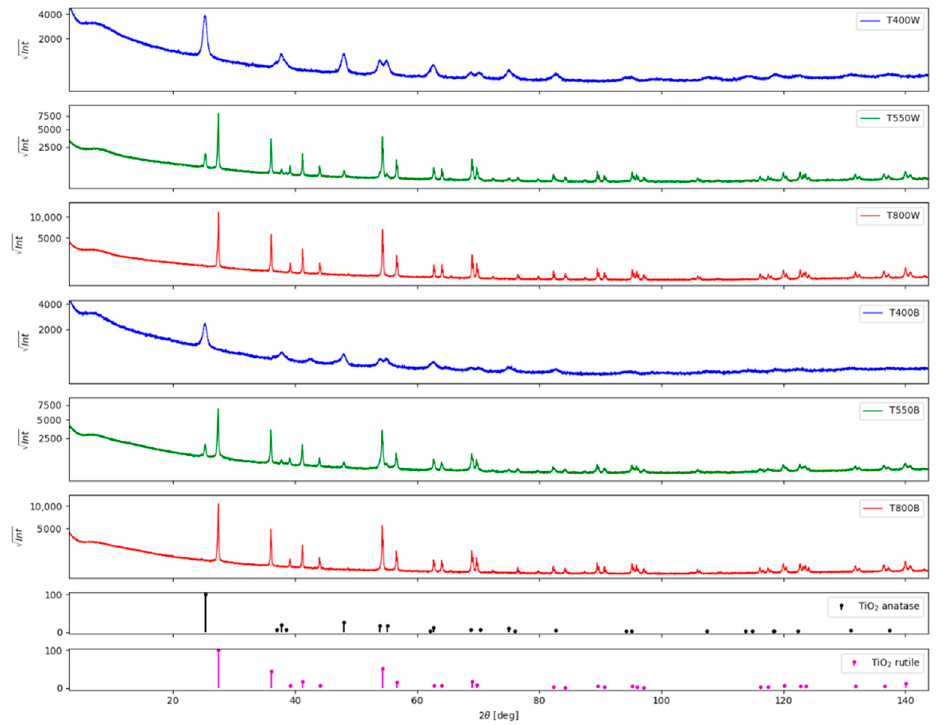
Figure 1. XRD patterns of white and black titanium oxide samples.